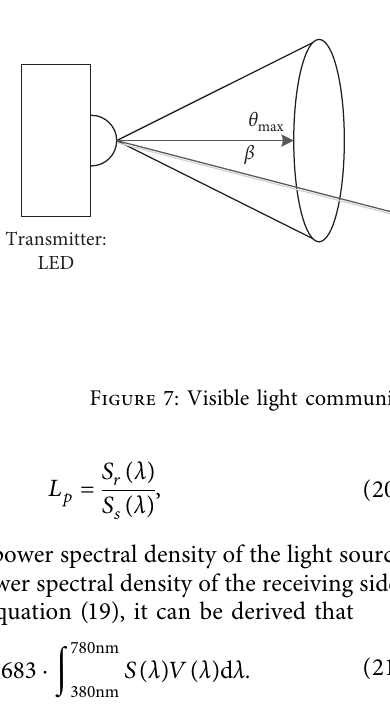
Figure 6: Variation of emitted power with